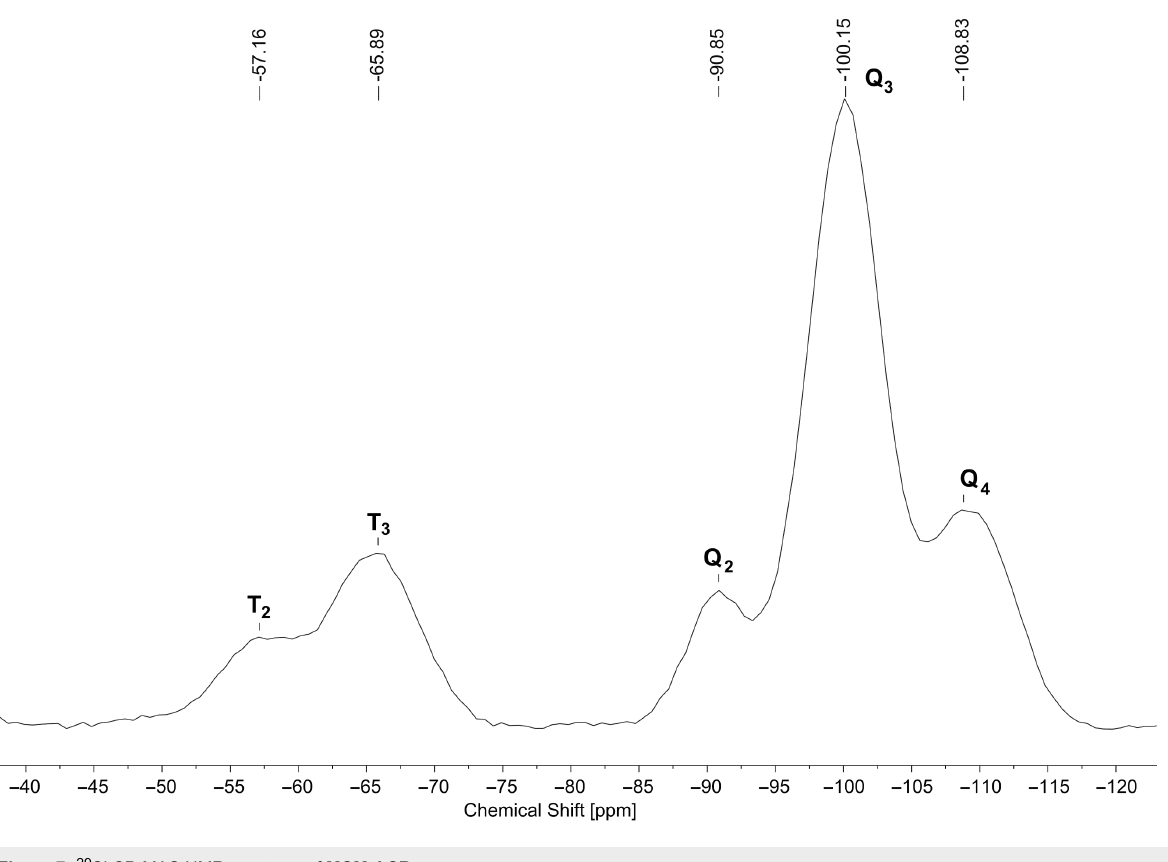
Figure 7: 29 Si CP-MAS NMR spectrum of MCM-ACR .